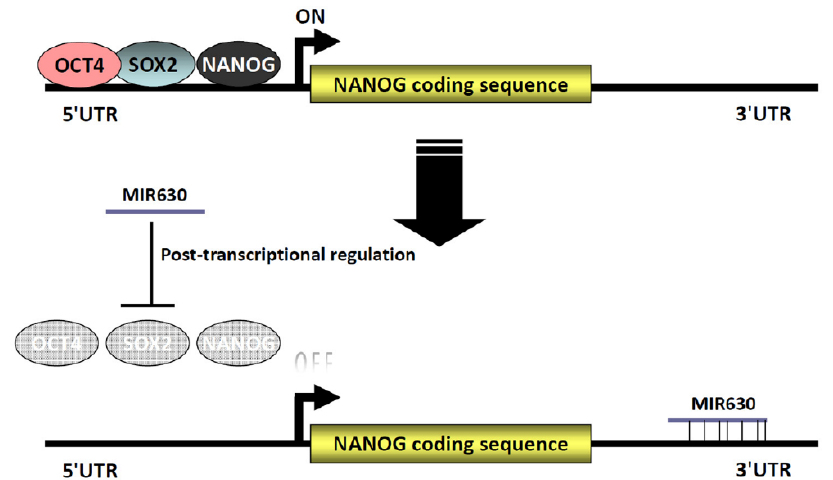
Figure 5. A schematic diagram depicting the MIR630-repressed NANOG expression via transcrip- tional and post-transcriptional regulation. We propose that MIR630 represses NANOG through transcriptional and post-transcriptional regulation. Transcription of NANOG is regulated by the OCT4/SOX2 complexes through an adjacent pair of highly conserved composite Sox-Octamer ele- ment in the 5 ′ -flanking region of the NANOG promoter. In addition, NANOG autoregulates its expression by binding to the proximal promoter. In the present study, we showed that MIR630 directly targets the NANOG , POU5F1, and SOX2 3 ′ UTRs to repress their expression. NANOG was further reduced due to the downregulation of NANOG, OCT4, and SOX2 levels.